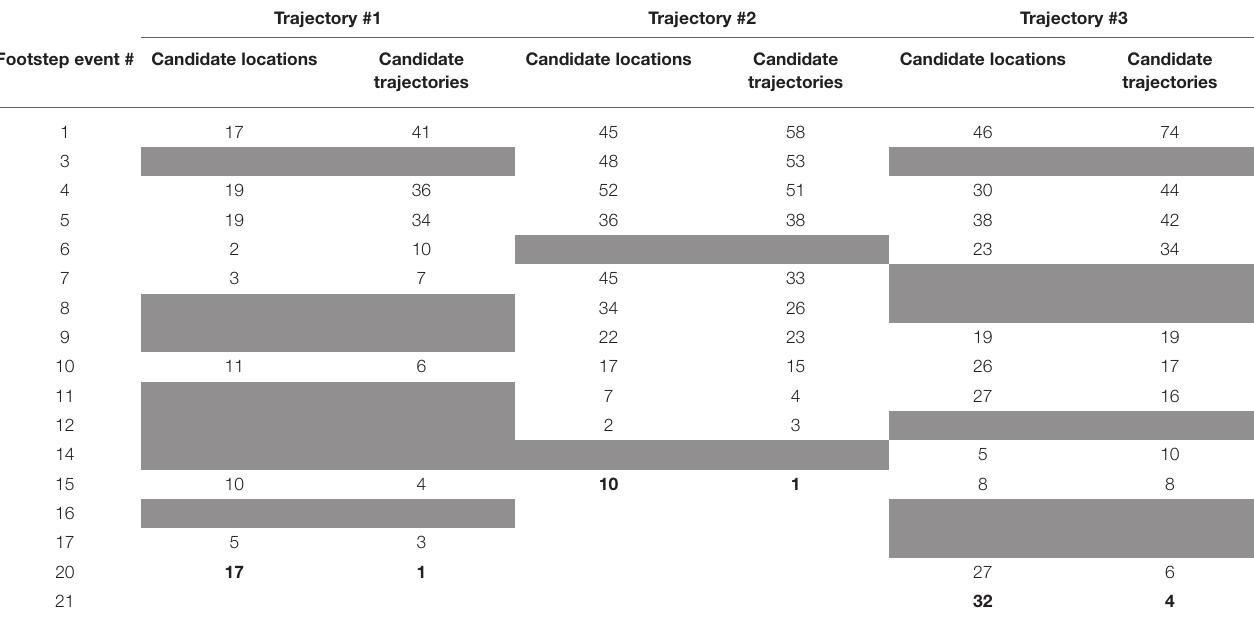
Blank gray fields correspond to footstep events that do not lead to a reduction in the number of candidate trajectories. Bold values correspond to final candidate trajectories and the candidate-location set of the last detected footstep event.